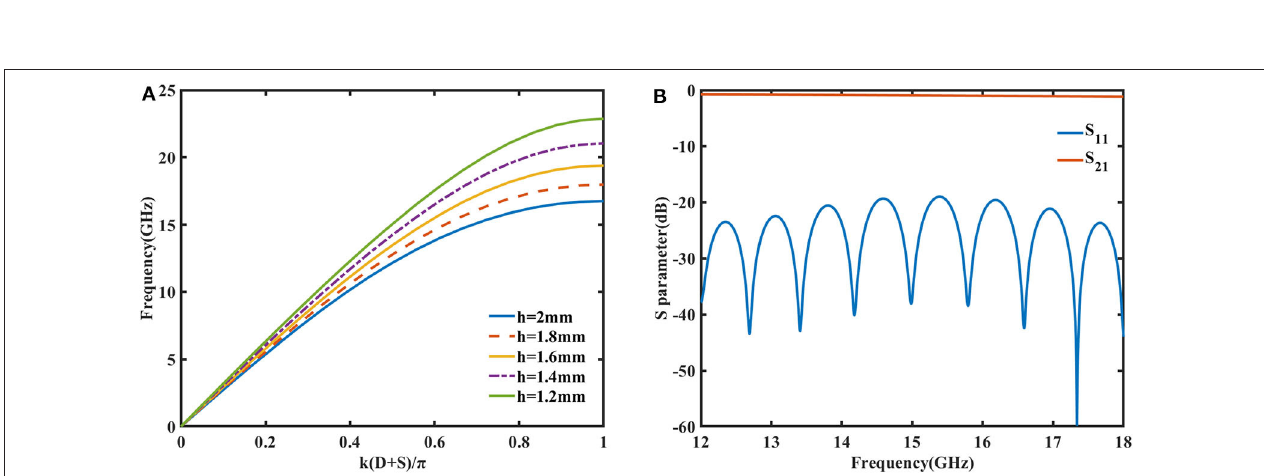
FIGURE 5 | (A) The dispersion curves of the spoof SPPs when the depth of groove h varies. (B) The simulated S parameters from the microstrip line to the spoof SPP TL when seven gradient grooves are adopted as the transition section.